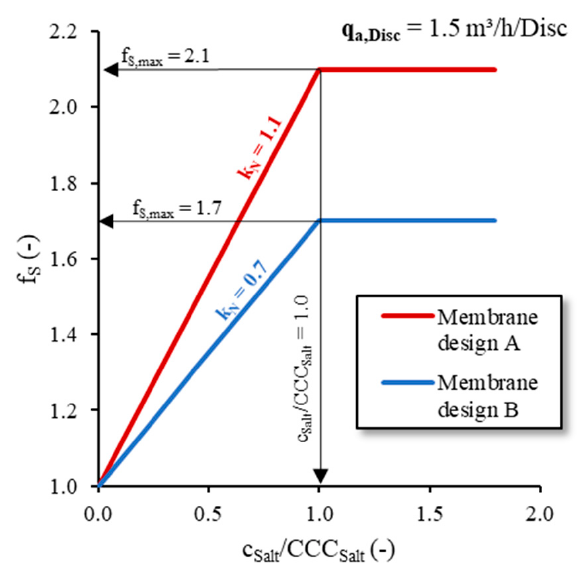
Figure 5. f S as a function of the dimensionless c Salt /CCC Salt ratio for both diffuser membrane designs for an airflow rate per disc diffuser of 1.5 m 3 /h/disc.